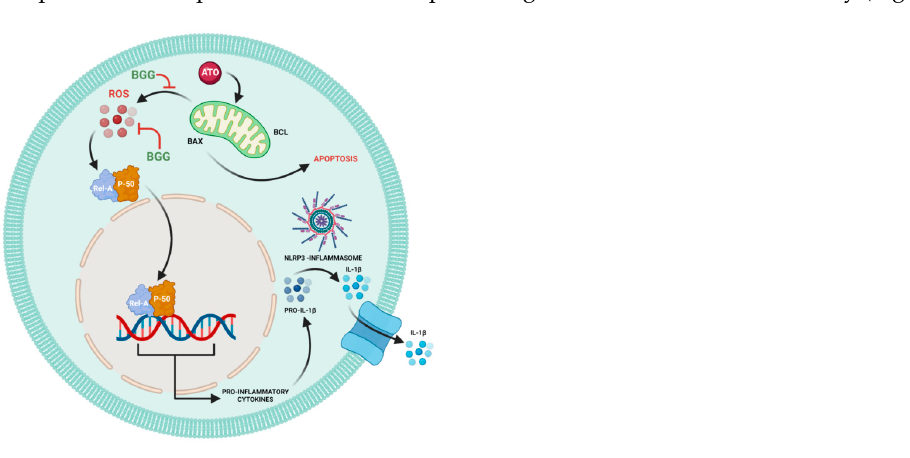
Figure 6. Schematic pathway of BGG attenuates ATO-induced toxicity in RAW 264.7 macrophages.